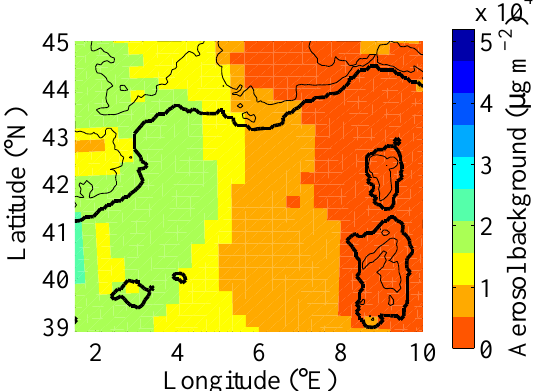
Fig. 16. Background aerosol loading in in µ g m − 3 from the CHIMERE simulation.